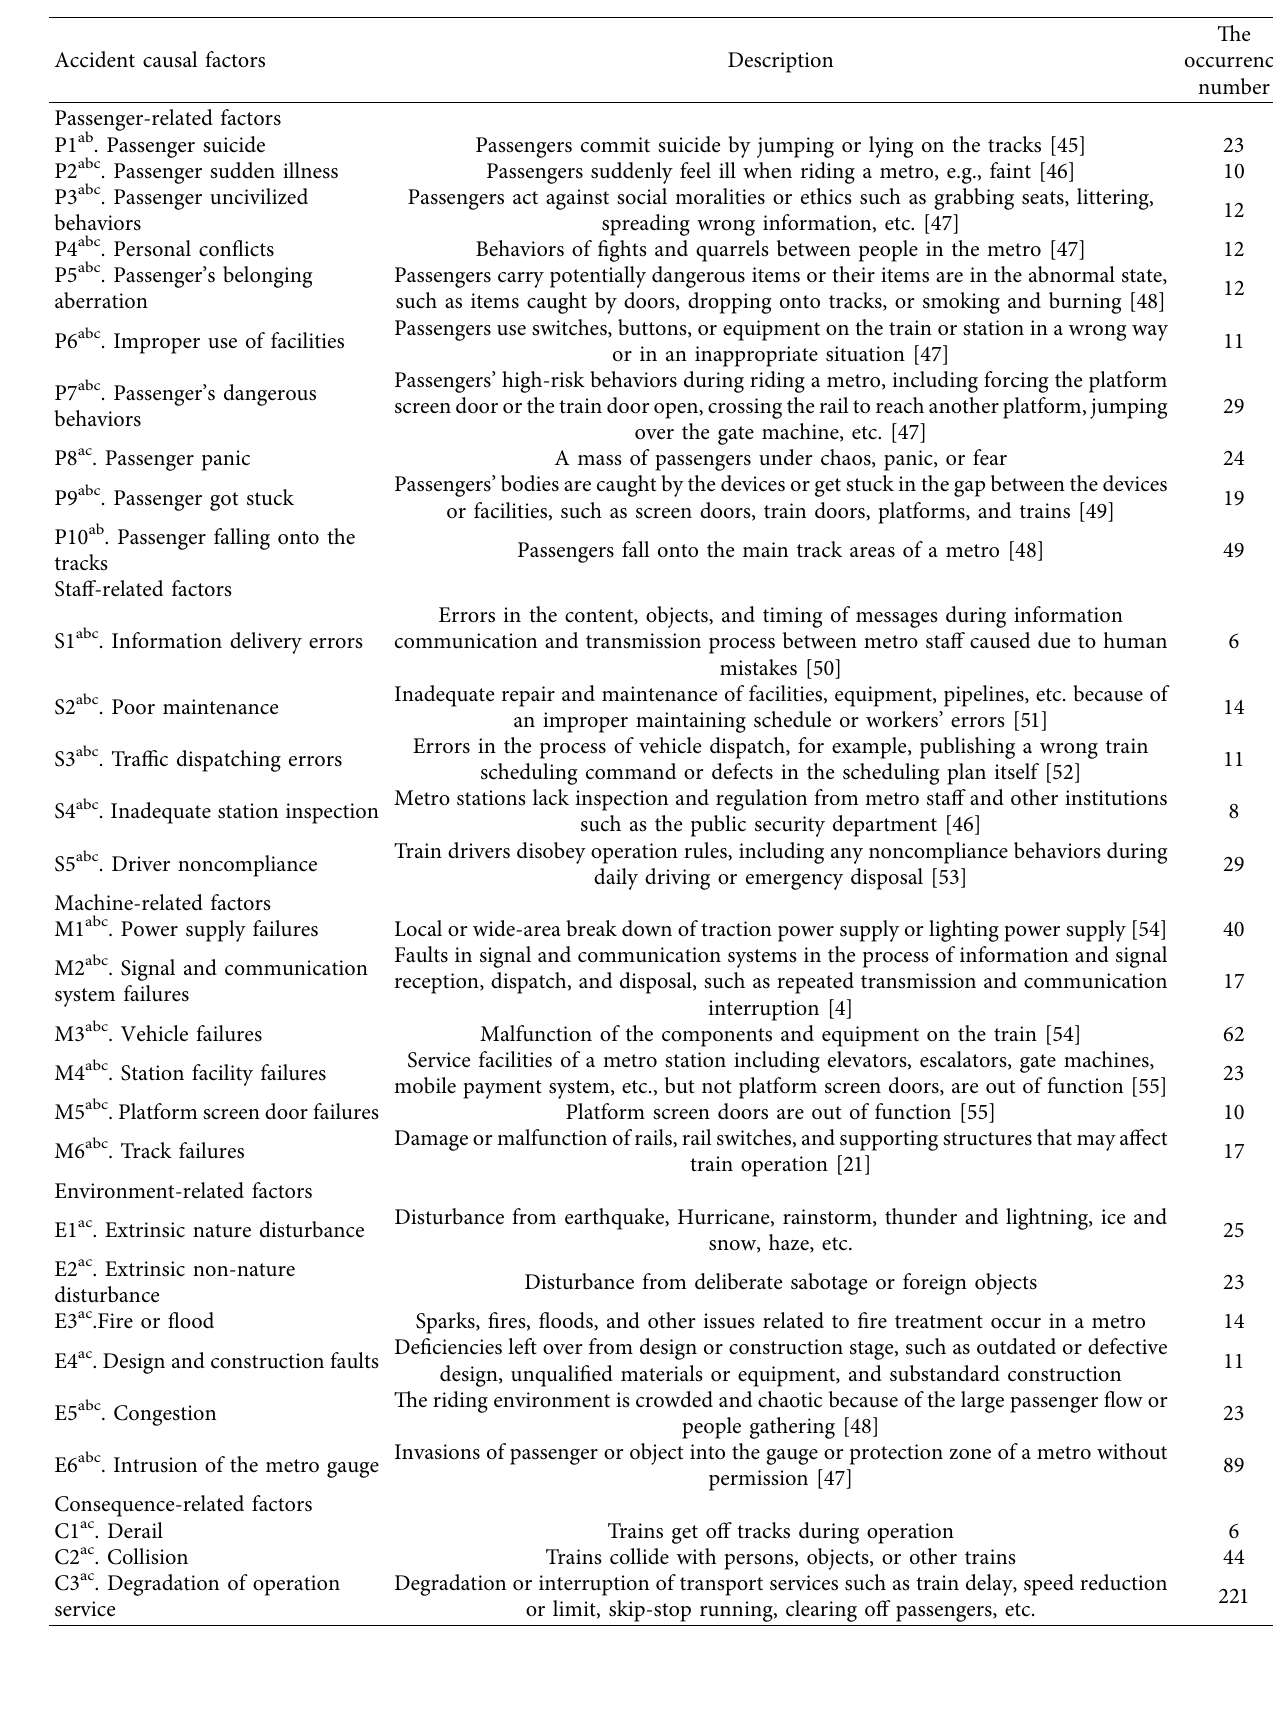
Table 1: Accident causal factor